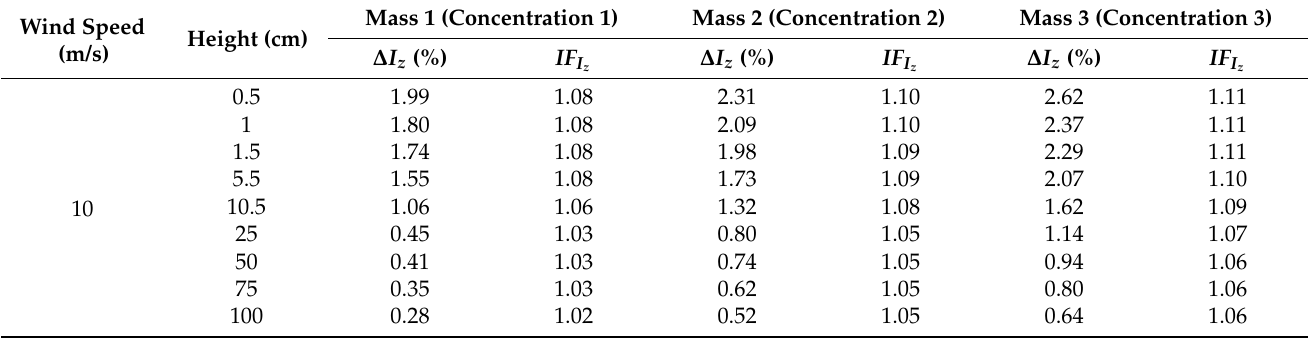
Table 3. The influence of moving grains on turbulence intensities at different